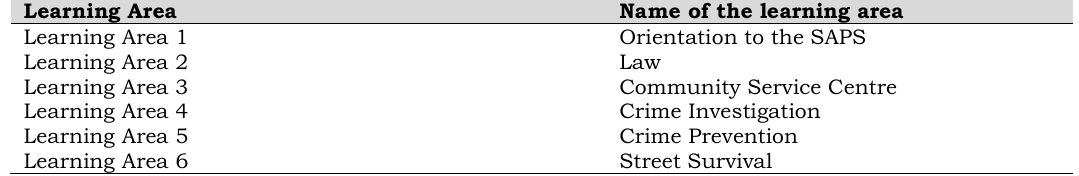
Table 1. The South African Police Service program (2015) called